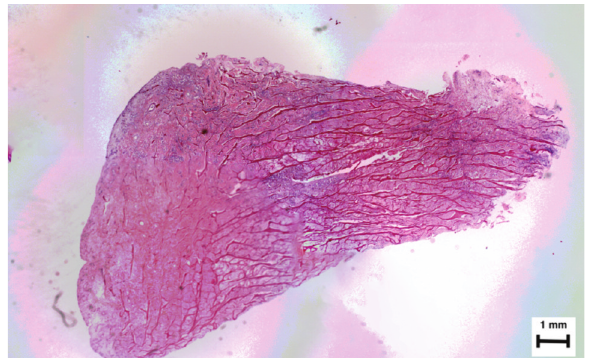
Excised fragment from the ruptured meniscal implant, Fig. 2: and its lines of sample cut for histology analysis.